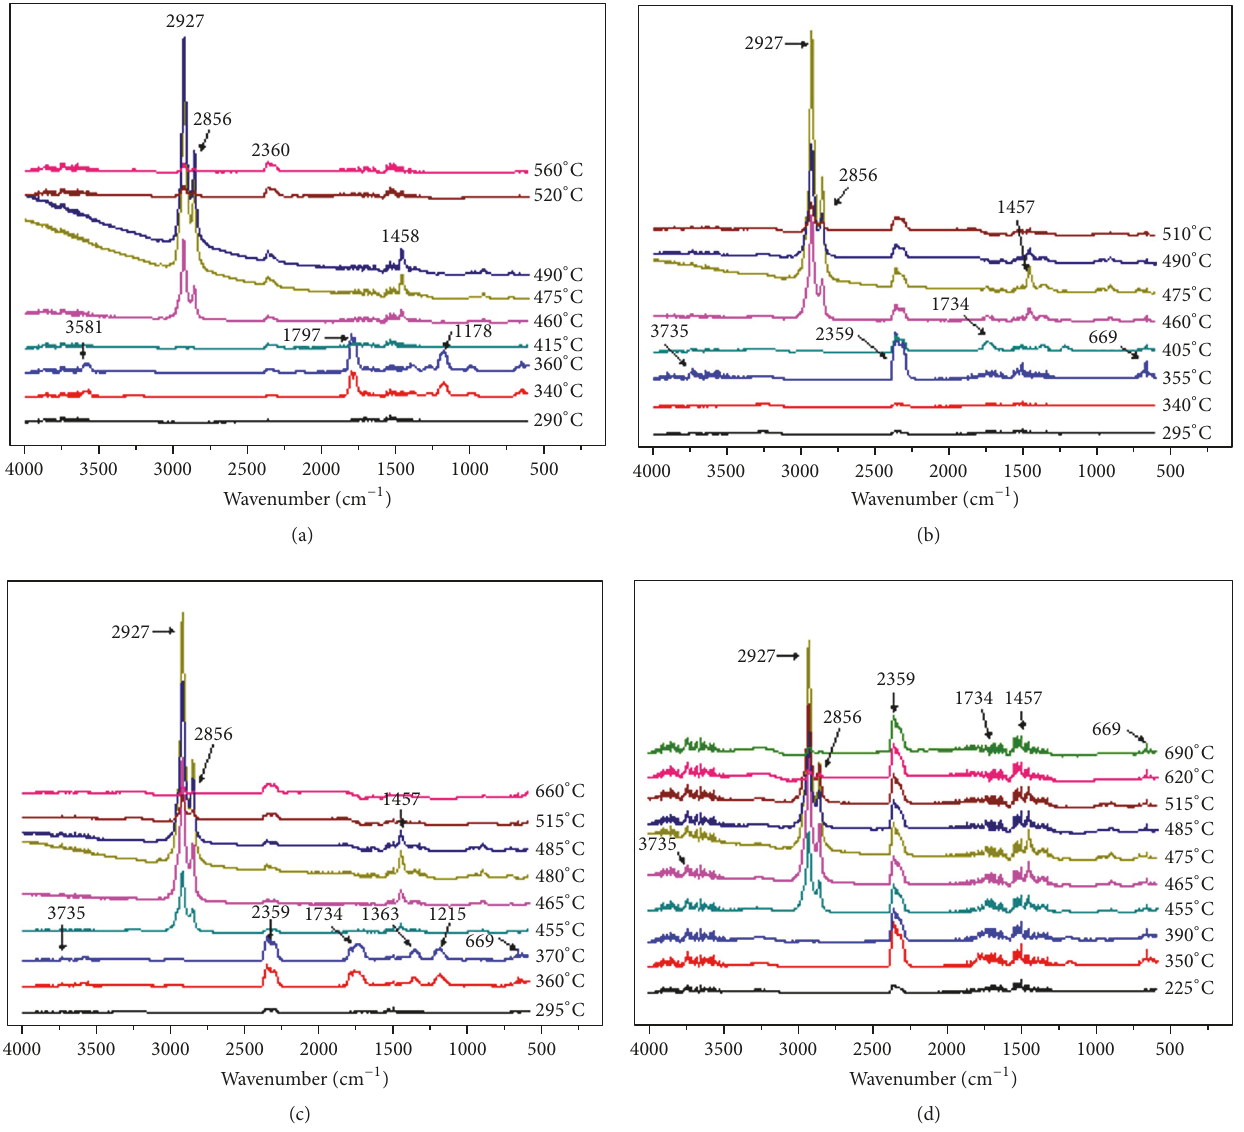
Figure 12: FTIR spectra of pyrolysis products of the composites at different temperatures: (a) EVA0, (b) EVA1, (c) EVA2, and (d)EVA3.